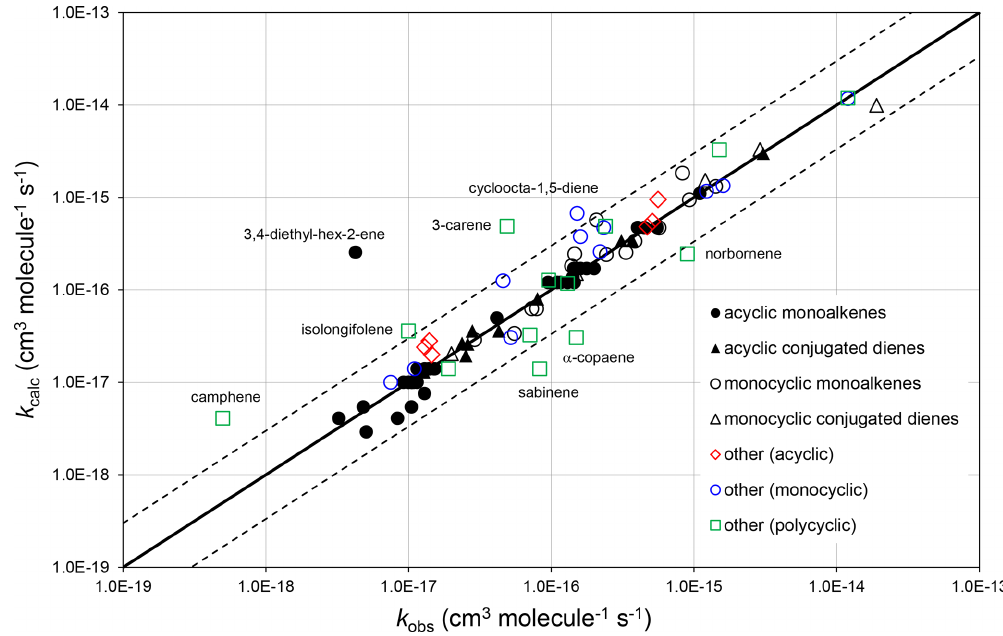
Figure 2. Scatter plot of observed and calculated values of k at 298K for the reactions of O 3 with monoalkenes and poly-alkenes, based on the parameters determined in the present work. The broken lines show the factor-of-3 range, within which the majority of data fall. Table 3. Optimized ring factors at 298K, F ring ( 298 ) , for the reactions of O 3 with cyclic monoalkenes, and their temperature dependences described by F ring = A F (ring) exp ( − B F (ring) /T )